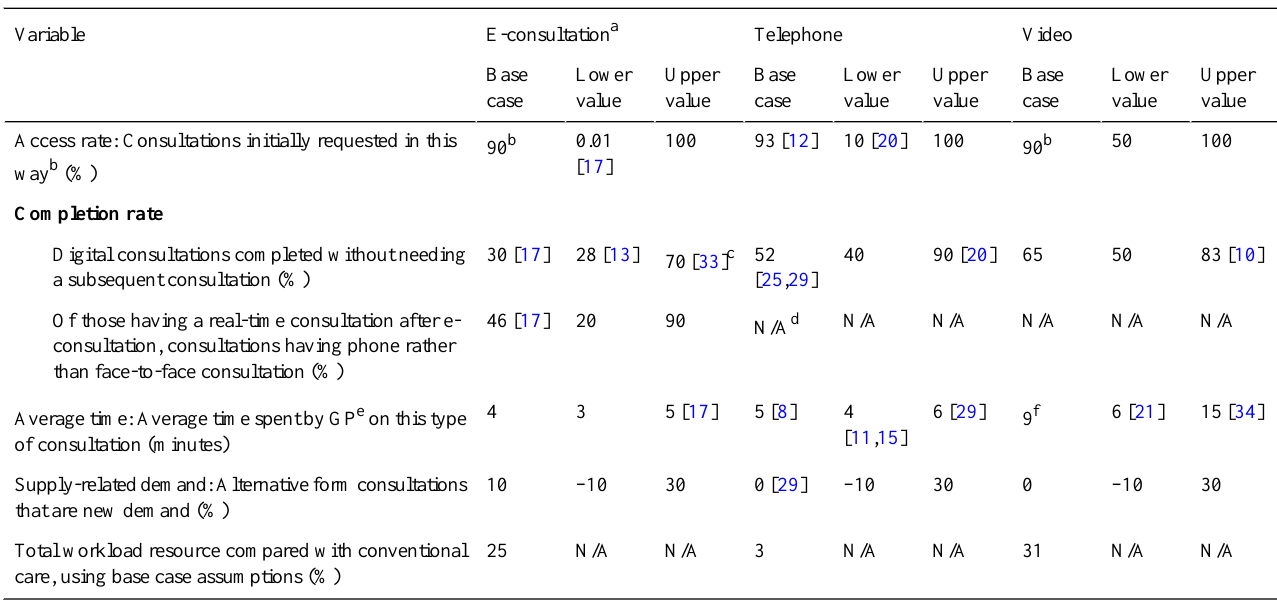
Table 1. Alternatives to face-to-face consultation: default values for variables in workload model. All values can be altered in the interactive model to test different scenarios and assumptions. Values without citations are authors’estimates.